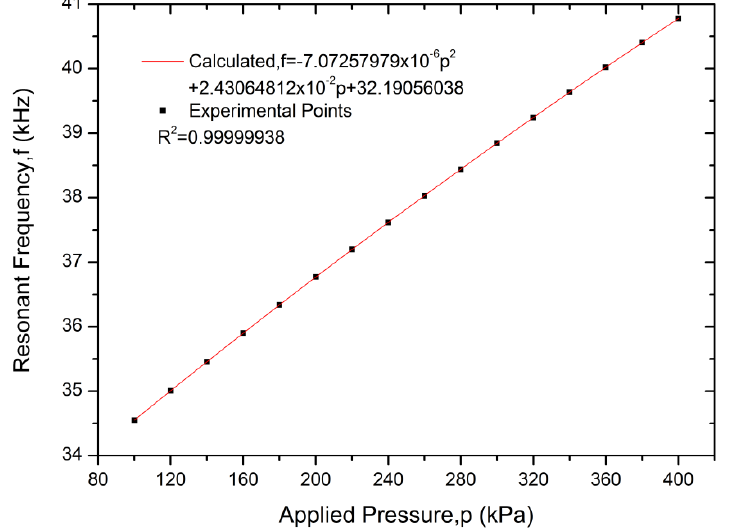
Figure 13. Resonant frequency with applied pressure at 20